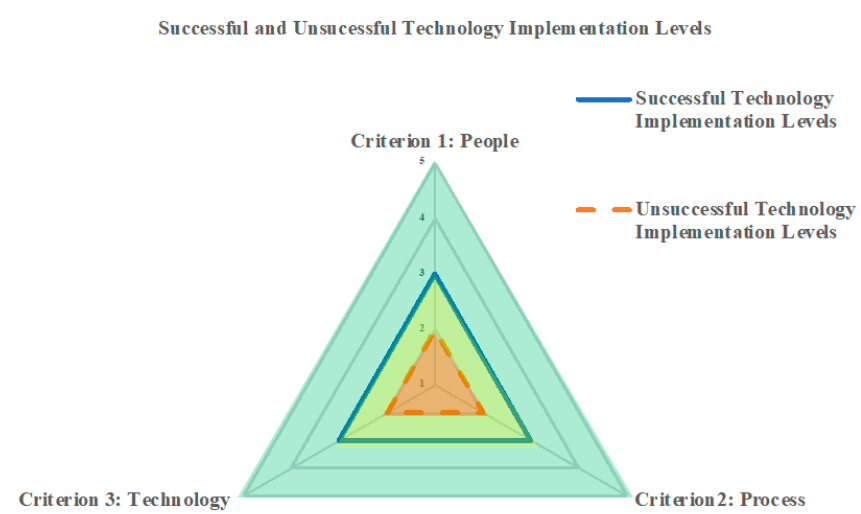
Figure 1. Levels of People, Process, and Technology for both successful and unsuccessful technology implementation. Table 2 provides a summary of the response rankings. Table 2. Number of responses ranking the implementation